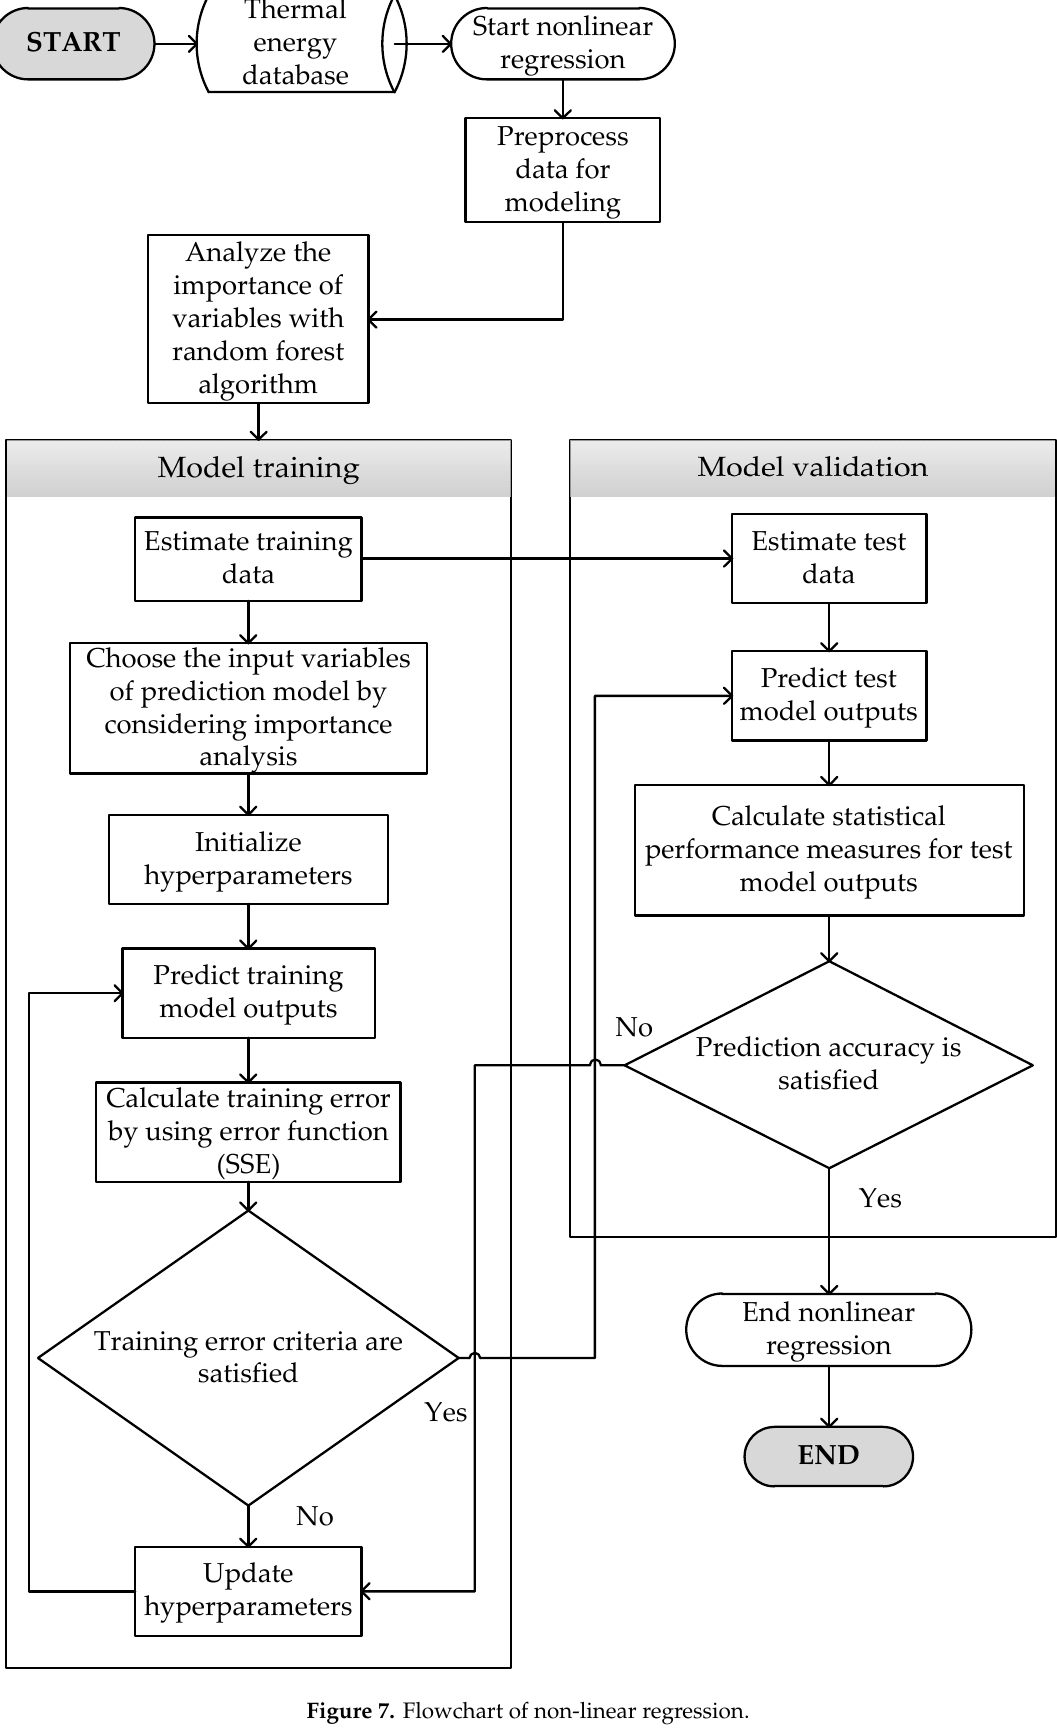
Figure 7. Flowchart of non-linear regression.